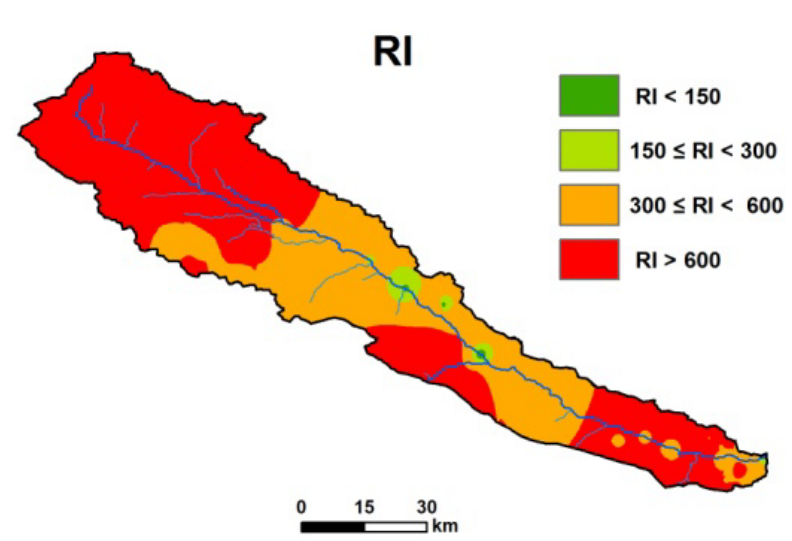
Figure 7. Interpolated RI map and spatial distribution of potential ecological risk regions.